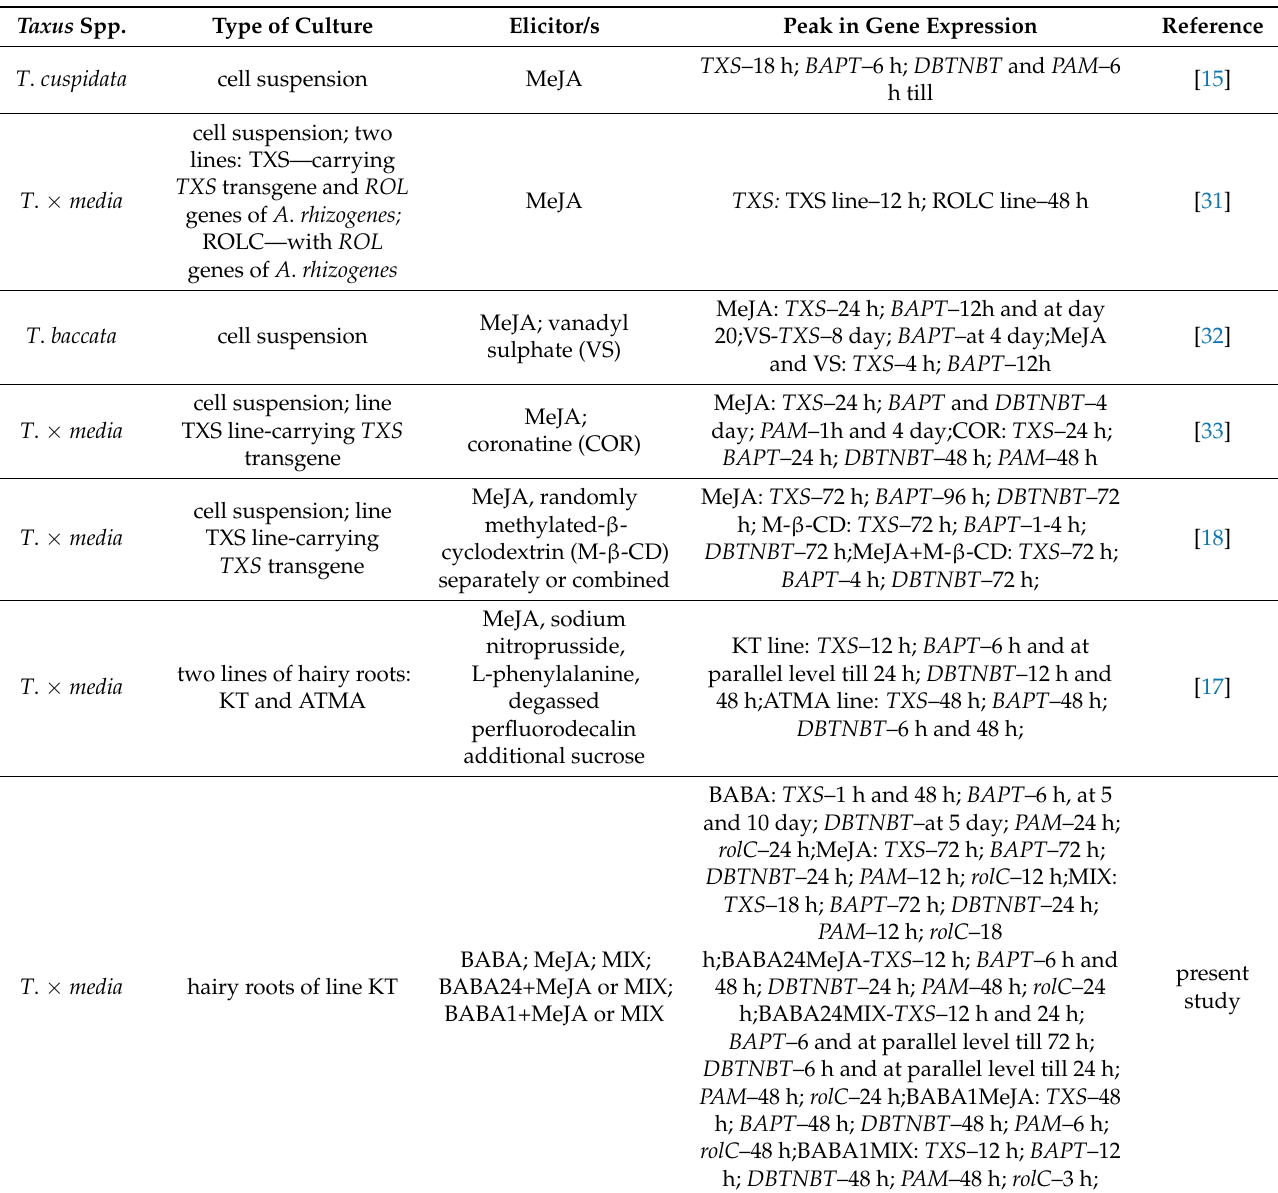
Table 1. The effect of culture conditions on changes in taxane biosynthesis gene expression